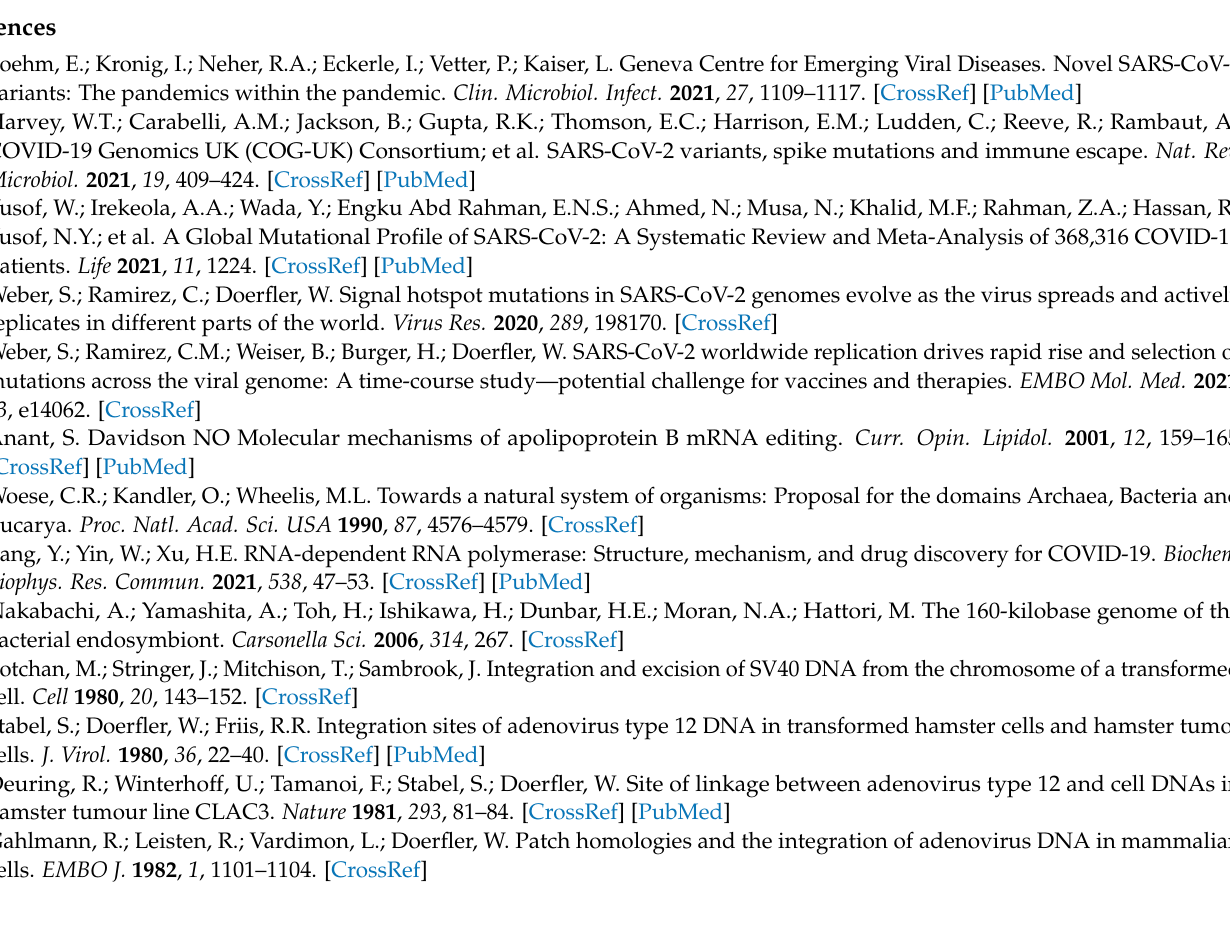
Figure S5A,B—parts of the analysis of the total E. coli genome versus SARS-CoV-2 ; Table S1—accession numbers for analyzed sequences; Table S2—actual numbers the bar graphs in Figure 6 were de- rived